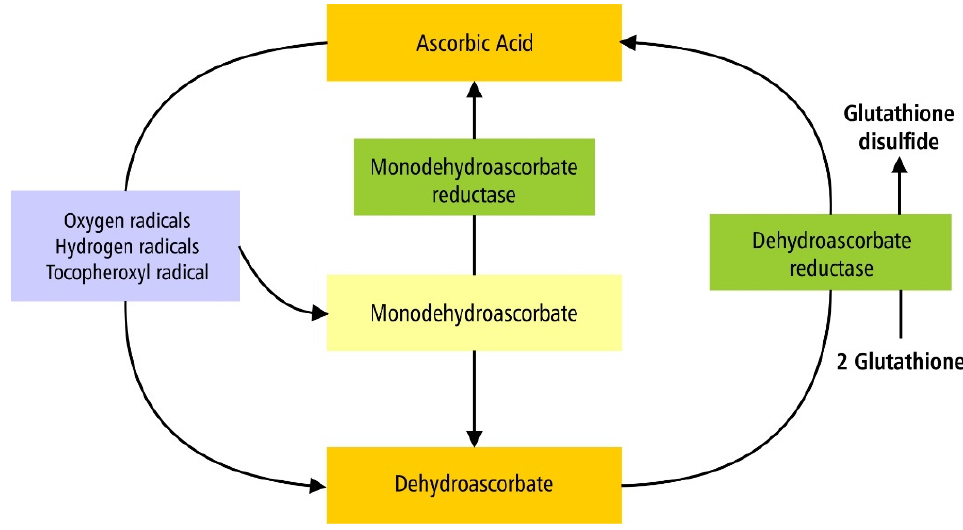
Figure 1. Ascorbic acid decay and regeneration cycle.